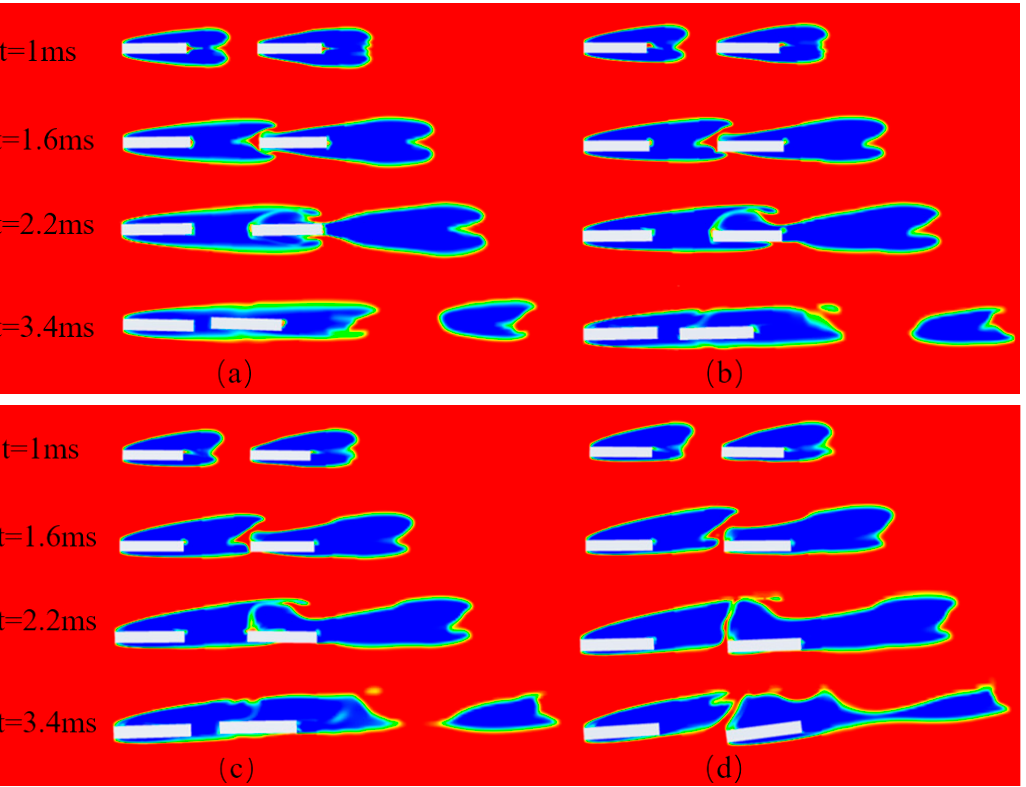
Figure 17. Cavity evolution of the tandem projectiles under different conditions: ( a ) no lateral flow; ( b ) the lateral flow velocity V c = 3.75% V p ; ( c ) V c = 7.5% V p ; ( d ) V c = 11.25% V p.